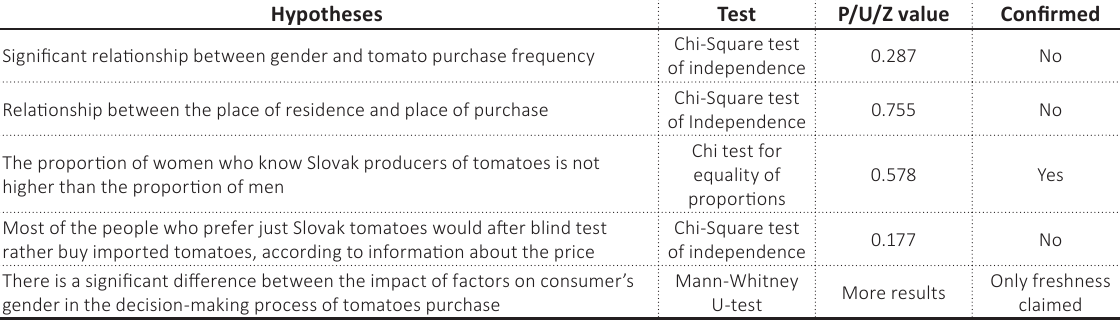
Source: Authors (2019).